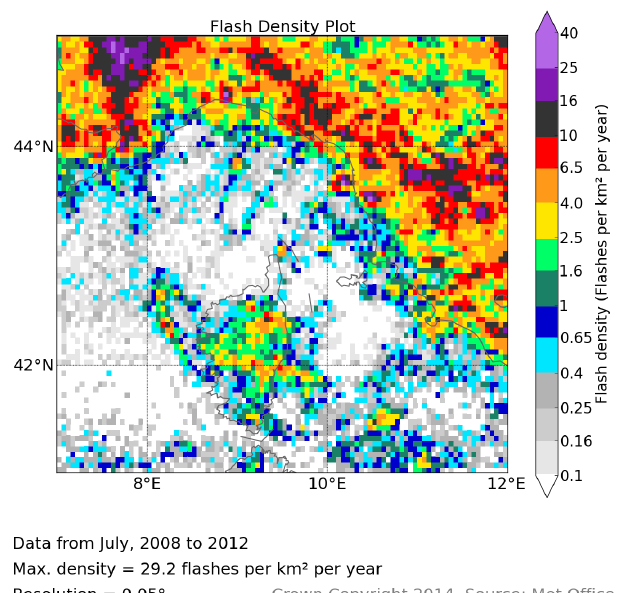
Fig. 21. Monthly average flash detections for latitude bands across Europe, along with the cumulative distribution, for 30–40 ◦ N (top left), 40–50 ◦ N (top right), 50–60 ◦ N (bottom left), and 60–70 ◦ N (bottom